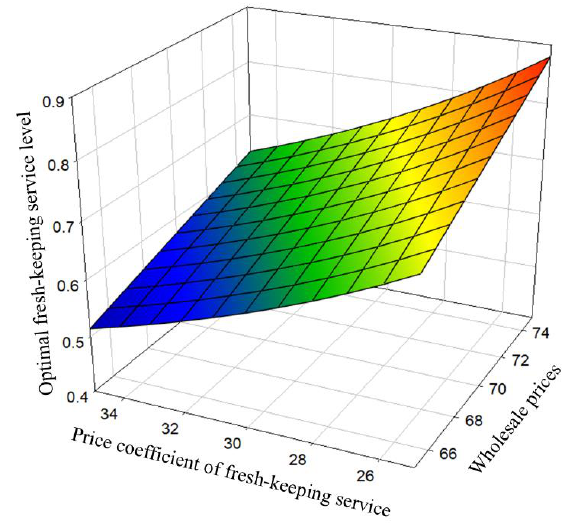
Figure 3. The impact of the fresh-keeping service price coefficient and the wholesale price on the optimal fresh-keeping service level selected by manufacturers.